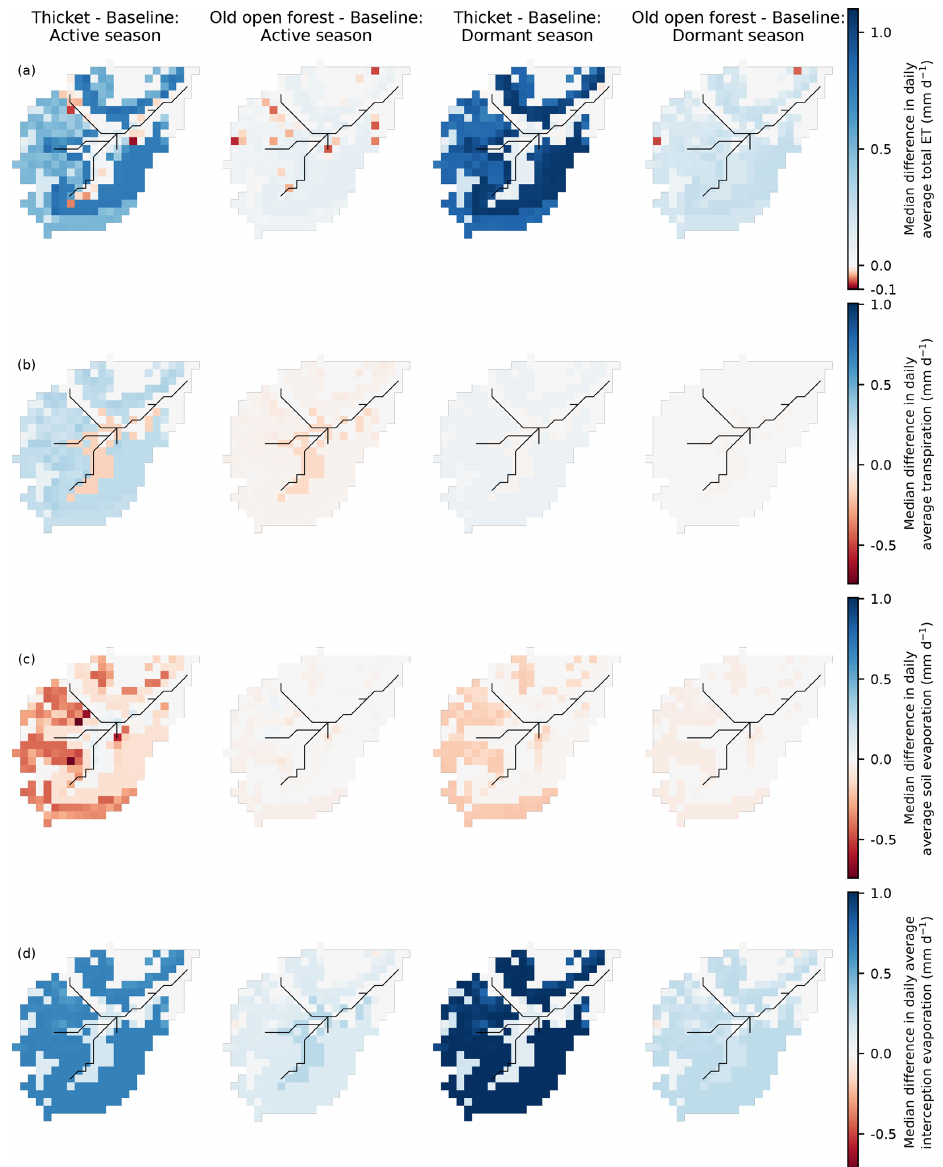
Figure 8. Maps showing the median difference in daily average green fluxes for the active (April to September) and dormant (October to March) seasons. (a) Total evapotranspiration (ET). (b) Transpiration. (c) Soil evaporation. (d) Interception evaporation. Differences are reported as regeneration scenario minus baseline scenario. Note that total ET is on a different scale to the other